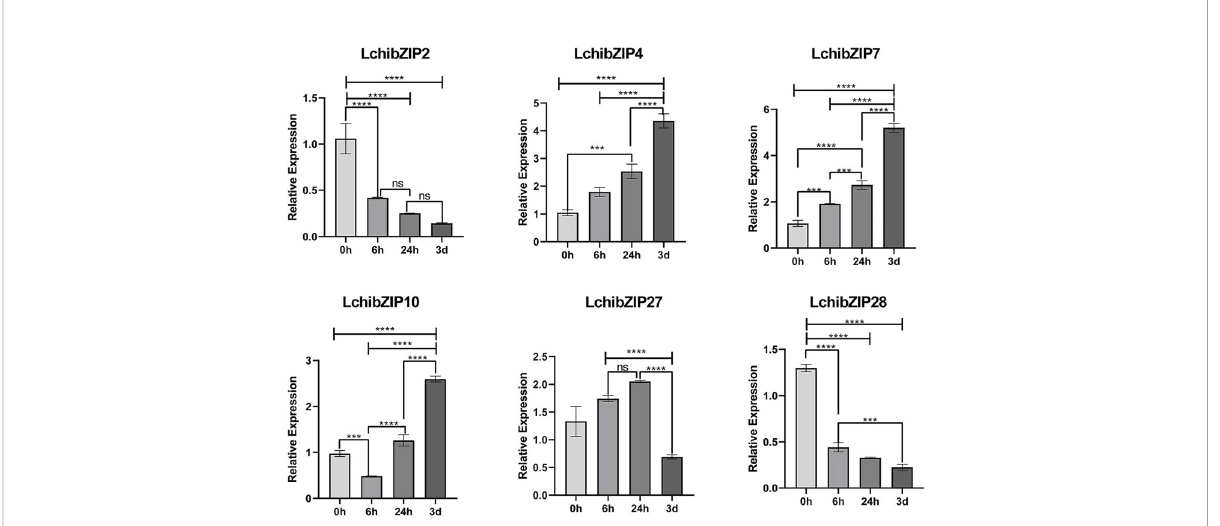
FIGURE 11 Expression analysis of 6 representative genes of L.chinense bZIP family under cold stress. The **** and *** indicate signi fi cant differences of p<0.0001 and p<0.001. The ns indicate no signi fi cant